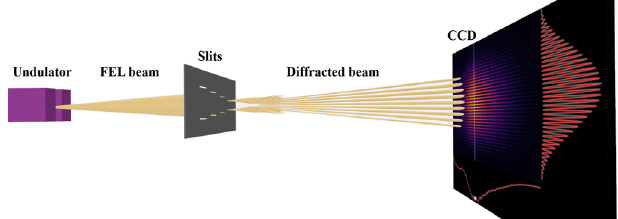
FIG. 2. Young ’ s double-slit setup used to measure transverse coherence. After the last radiator section, the photon pulse reaches the slits. For the experiment, we used slits with different separations, i.e., 0.4, 0.6, 0.8 and 1 mm, placed symmetrically with respect to the center of the beam spot, whose dimension was about 3 mm (FWHM). The pulse diffracted by the slits was recorded using a CCD of 1024 by 1024 pixels, with pixel width of 13 . 3 μ m. The distance between the slits and the CCD was about 8.6 m.